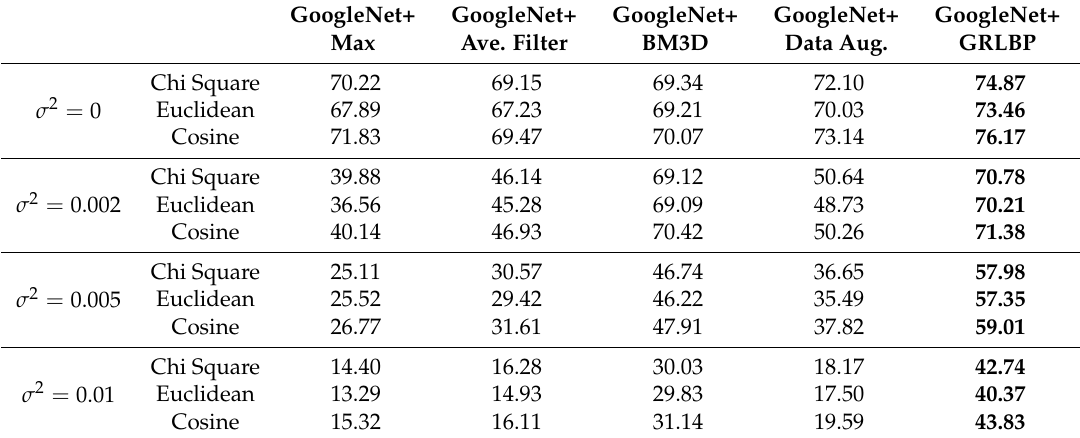
Table 9. The recognition rates (%) of different pooling methods, the average filter, the BM3D algorithm, and data augmentation based on the GoogleNet on the AR database with different Gaussian